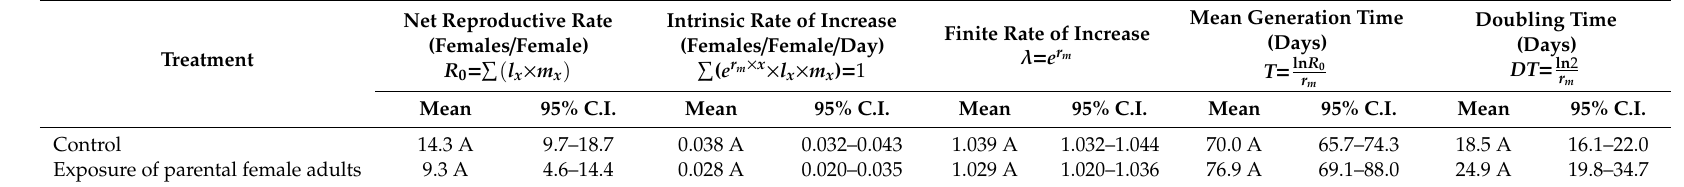
Table 3. Values of net reproductive rate ( R 0 ), intrinsic rate of increase ( r m ), finite rate of increase ( λ ), mean generation time ( T ), and doubling time ( DT )